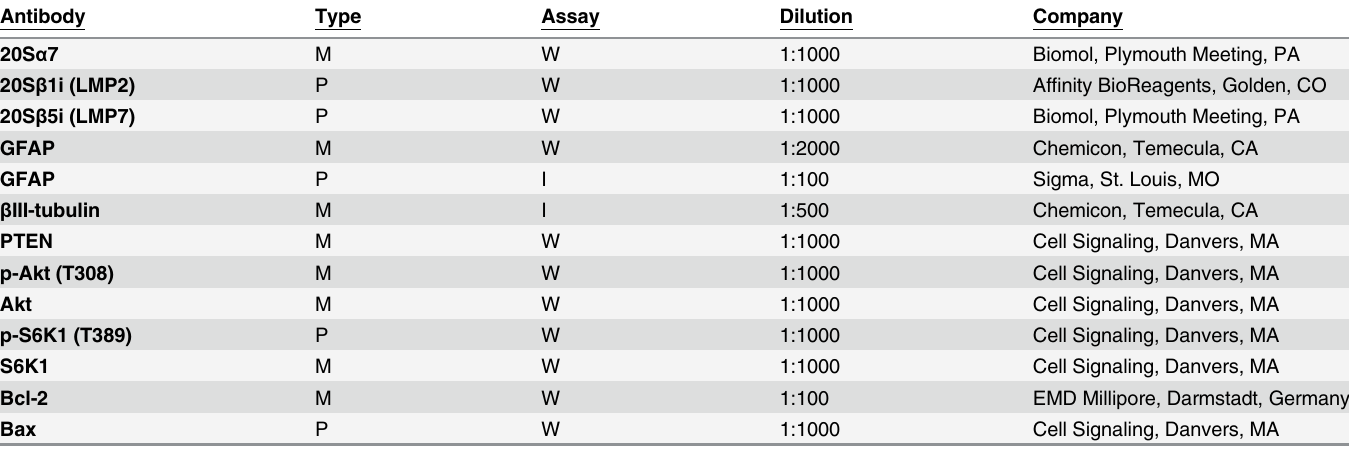
Table 1. Antibodies used for Immunohistochemistry or Western Immunoblotting. Antibody Type Assay